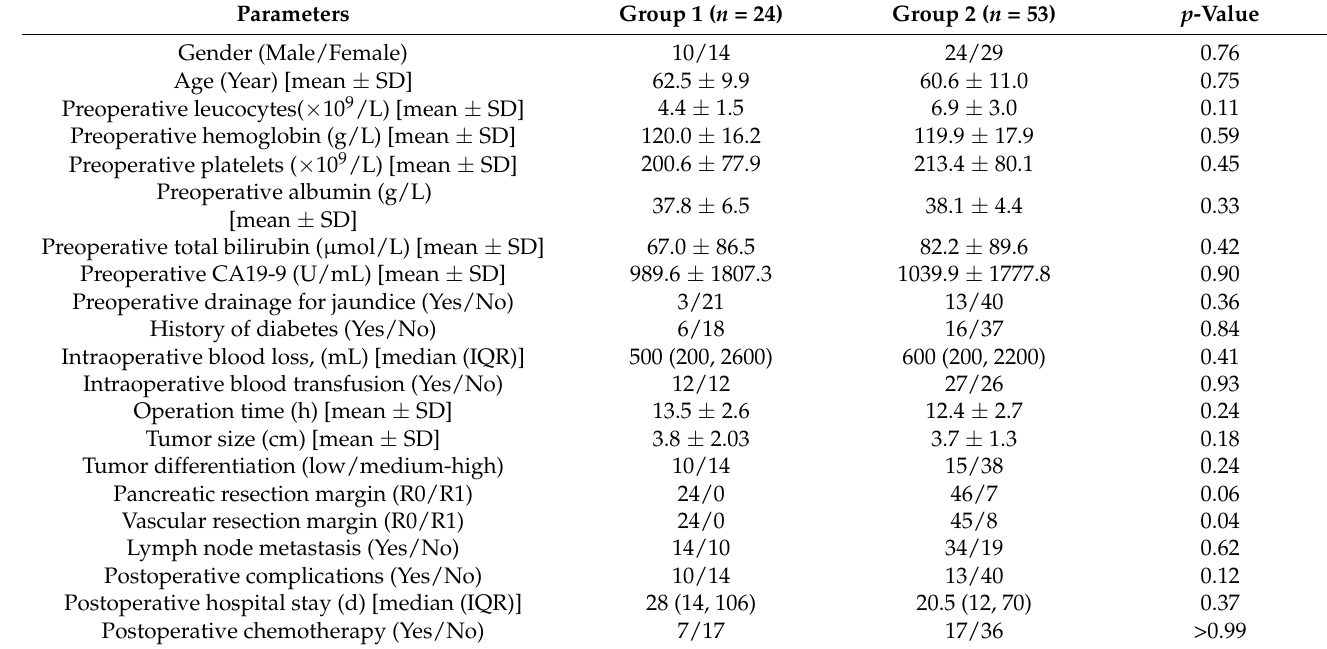
Table 1. Comparison of the general information between the two groups.